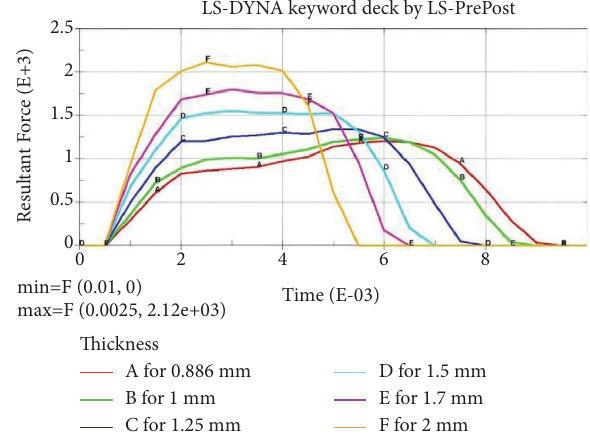
Figure 12: Impact force.